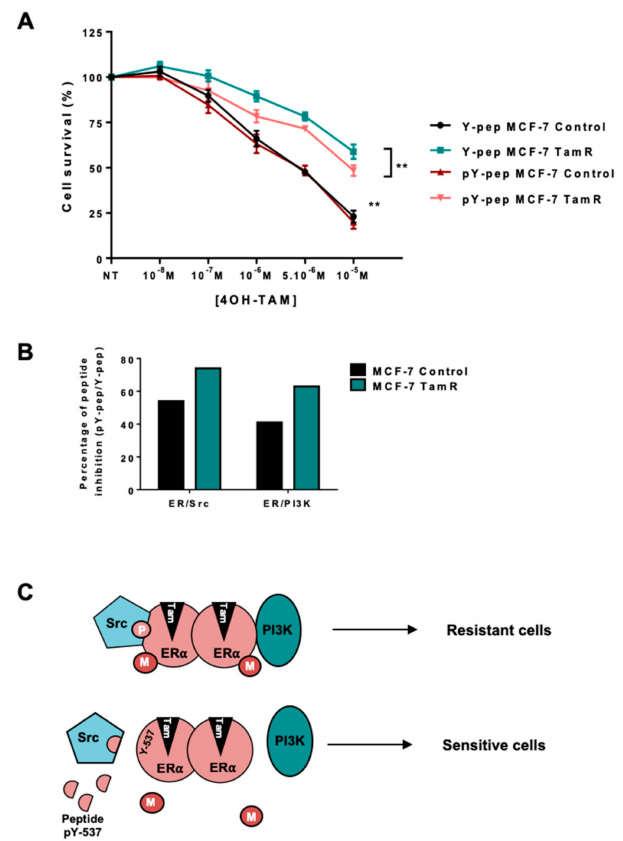
Figure 5. Targeting the ER α / Src dimer in MCF-7 Res-Tam cells. ( A ) Parental and Res-Tam MCF-7 cells were incubated with 1 nM of a peptide mimicking hER α 536-541 containing Y537 (Y-pep) or the corresponding phosphorylated peptide (pY-pep) for 30 min prior to treatment. We then assessed their response to increasing concentrations of tamoxifen using an MTS cytotoxic assay. ( B ) ER α / Src and ER α / PI3K interactions were determined by proximity ligation assay after treating MCF-7 cells with pY-pep or Y-pep. Quantification of the number of dots per cells was performed as previously described and the percentage of peptide inhibition was calculated (pY-pep / Y-pep). ( C ) Model of oestrogen non-genomic signalling in tamoxifen-resistant BC. M corresponds to methylation and P to